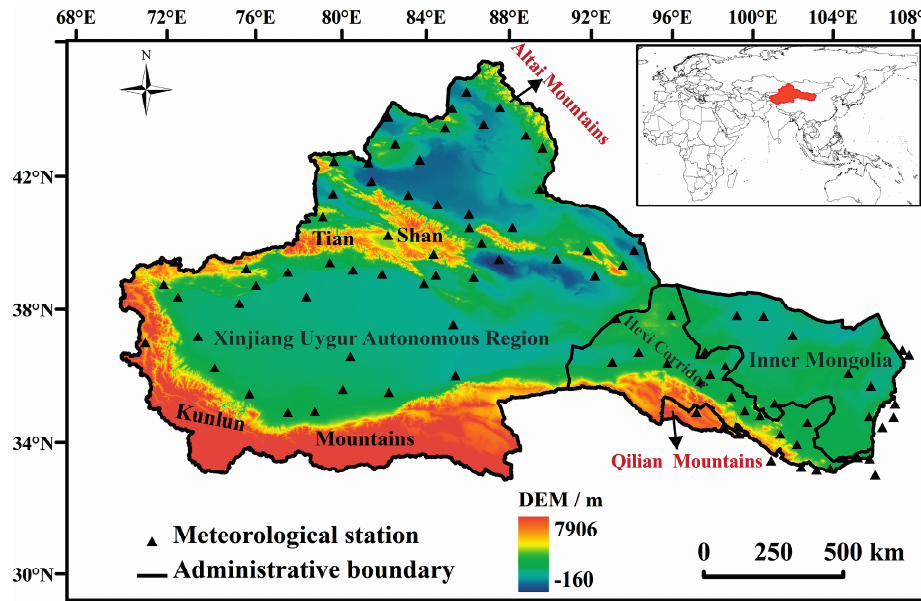
Figure 1. Map of the arid land of northwestern